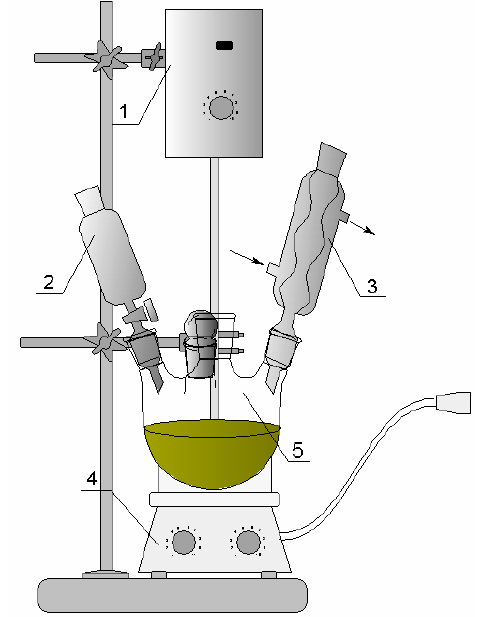
Figure 2. The scheme of the reaction set-up. 1 - mechanical stirrer; 2 - dropper with dry ethyl alcohol; 3 - reflux condenser; 4 - electric heater; 5 –